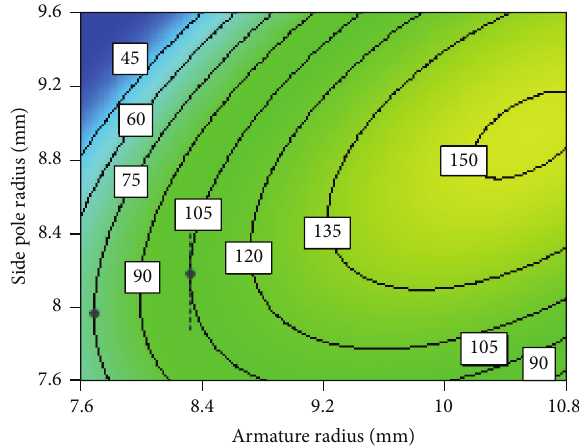
Figure 23: Interaction of armature radius and side pole